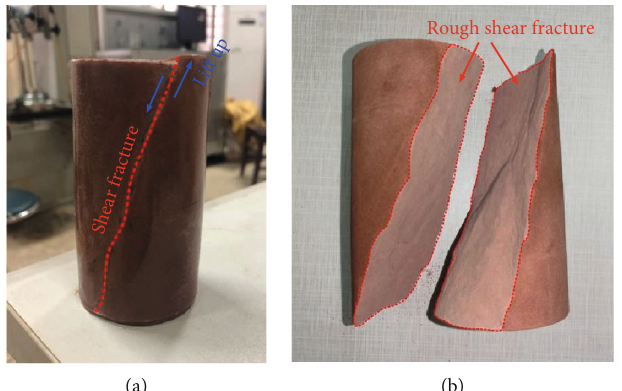
Figure 14: Picture of (a) fractured sandstone after seepage test and (b) rupture characteristics of fractures inside the specimen.